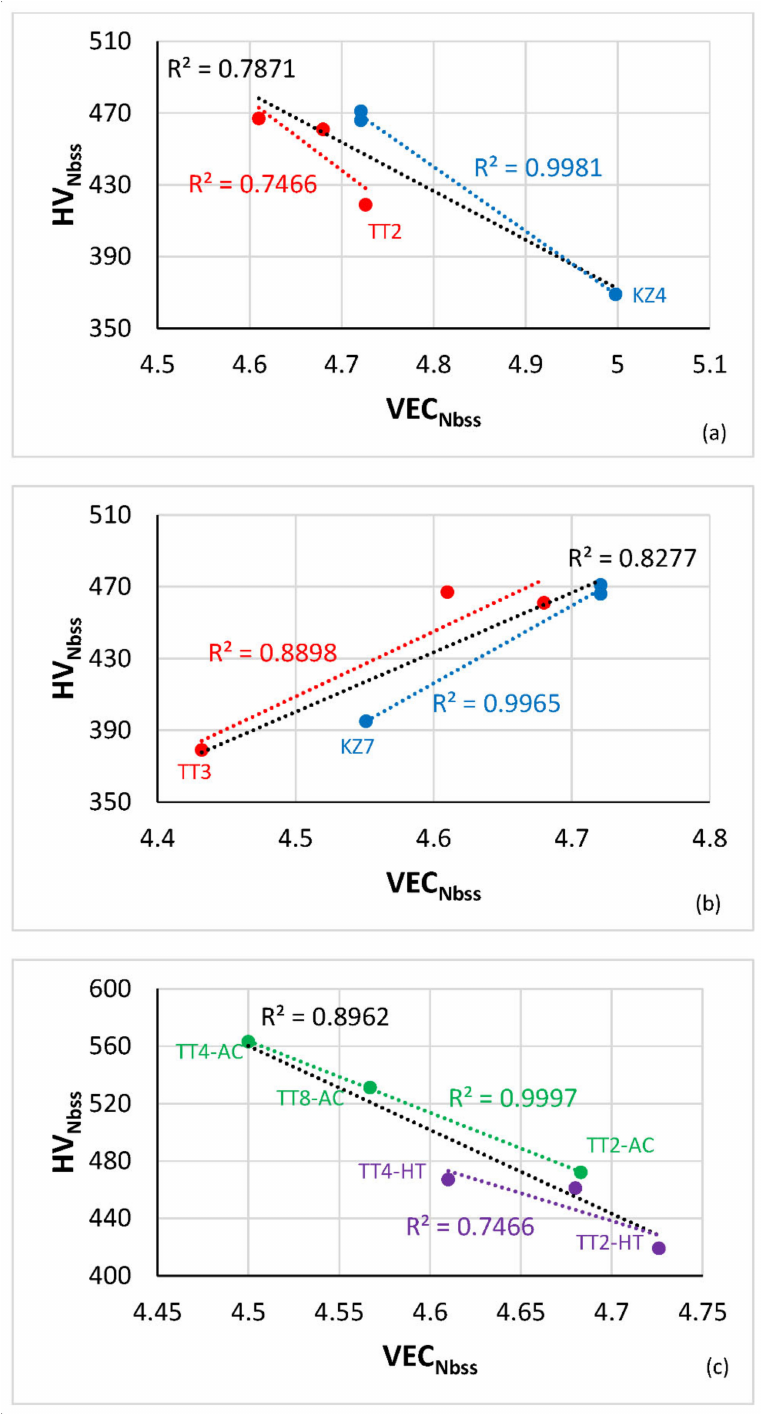
Figure 6. Vickers hardness (HV) of Nb ss in HT alloys versus the parameter VEC of the solid solution. ( a ) alloys TT2, TT4, TT8 (red), KZ4, KZ5 and JG3 (blue), all data R 2 = 0.7871 ( b ) alloys TT3, TT4, TT8 (red), KZ7, KZ5 and JG3 (blue), all data R 2 = 0.8277. ( c ) Vickers hardness of Nb ss in AC (green) and HT (purple) alloys TT2, TT4, TT8, all data R 2 =